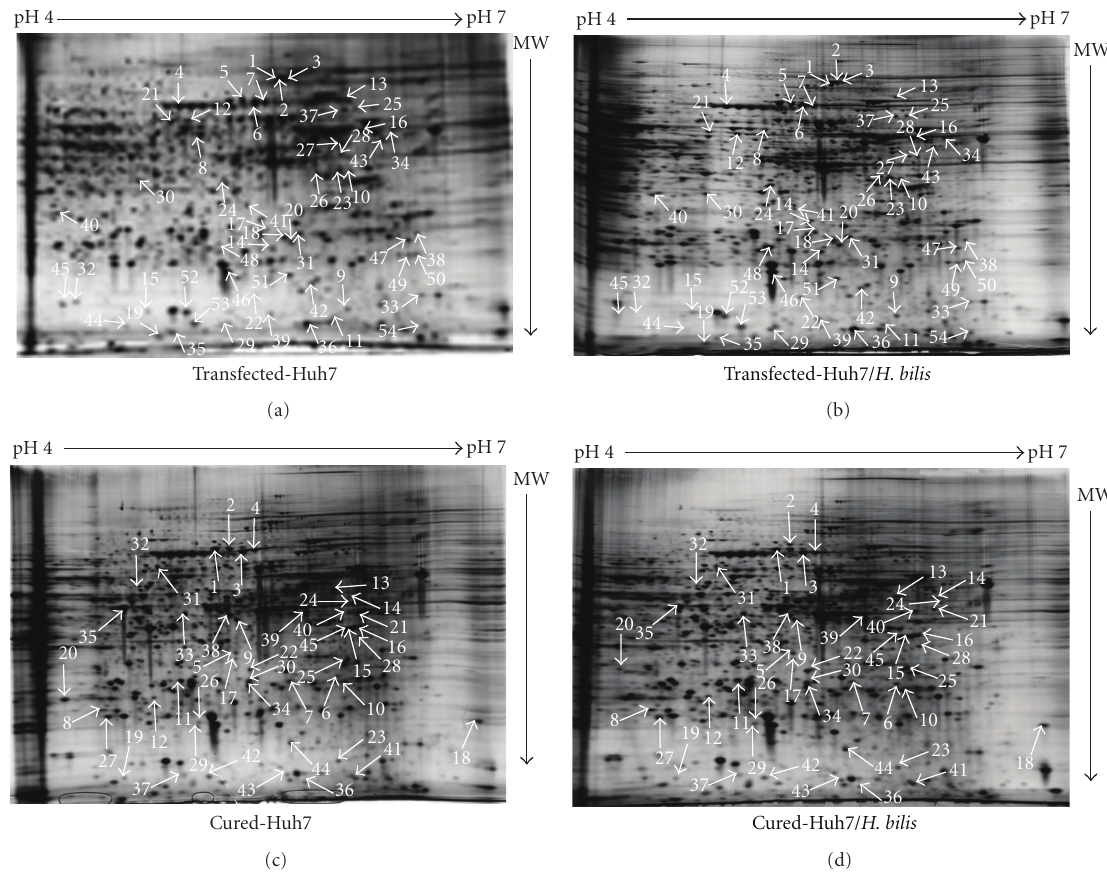
Figure 2: 2D-PAGE gels showing spots of soluble proteins of transfected and cured Huh7 cells in the pI 4–7 range. Gels (a) and (b) correspond to proteins of transfected Huh7 cells, gels (c) and (d) correspond to proteins of cured Huh7 cells. Cells were incubated in the presence of an initial H. bilis inoculum of approximately 10 3 cfu/mL. Protein spots in gels were visualised by silver staining. The spot intensities from triplicate gels of three independent experiments were determined using the Z3 computational software. Spots corresponding to proteins di ff erentially expressed are indicated on the